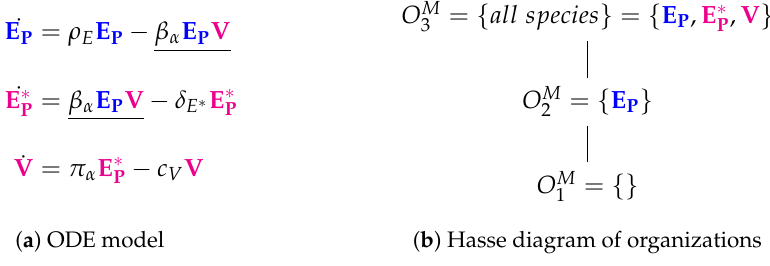
Figure 3. The Miao Model [14] with three variables: uninfected target cells ( E P ), productively infected cells ( E ∗ ) and free infectious influenza viruses ( V ). P